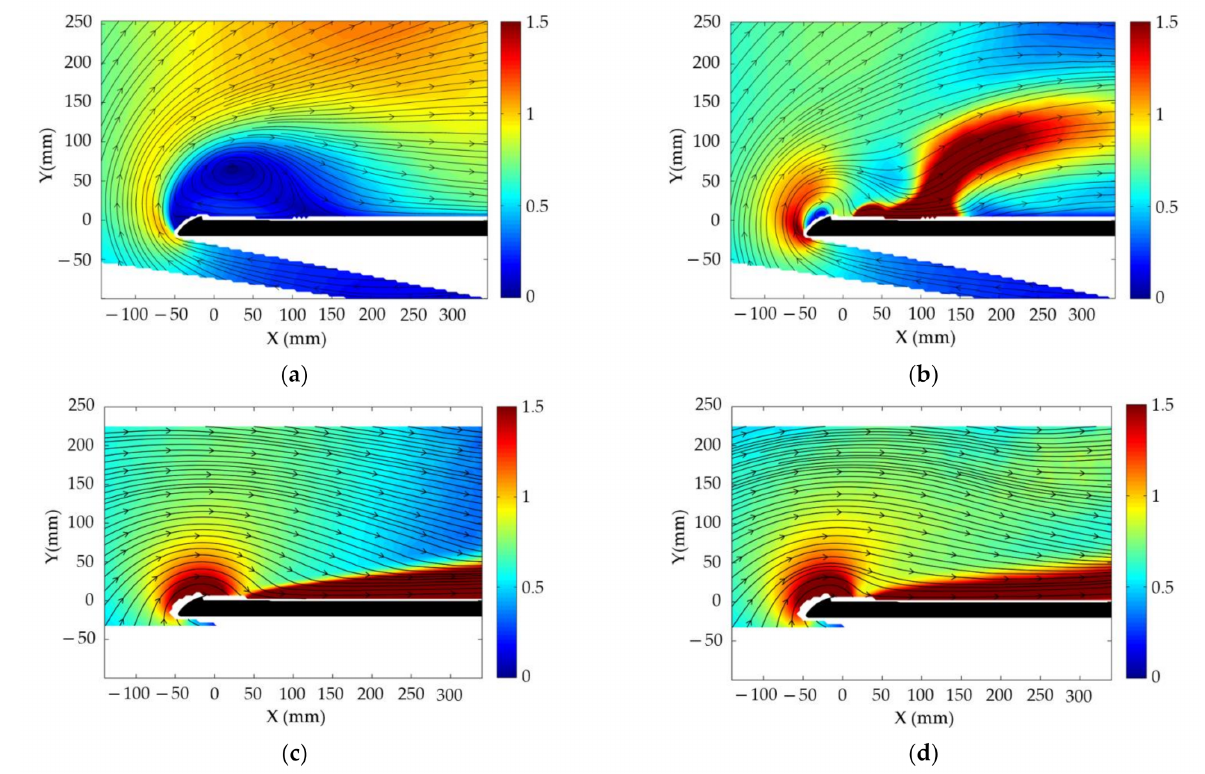
Figure 24. Flow in the area of side post and side wall. Diagrams with sectional streamlines of the mean flow field in the measuring level and contours of the three-dimensional velocity magnitude normalized by the mean inflow velocity: ( a ) fume hood with no flow control; ( b ) baseline fume hood, . S = 14.1 m 3 /h, C µ = 1.78; and ( d ) fume hood with oscillators,